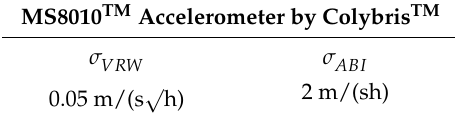
and accelerometer bias instability σ VRW